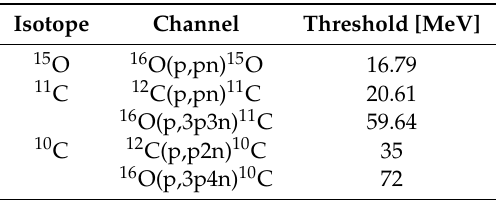
Table 1. Most relevant positron emitters produced in the target volume and production channels used in this